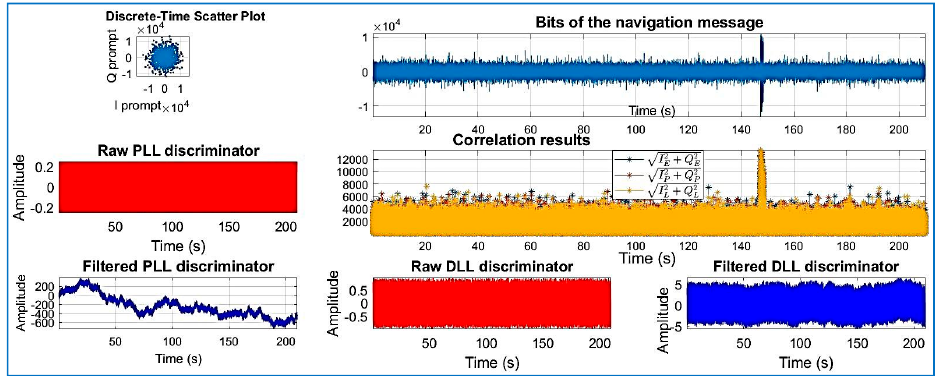
Figure 24. PRN 16, channel 6, Dataset 3. Observe how the raw discriminator is saturate. The software discarded the PRN after processing.